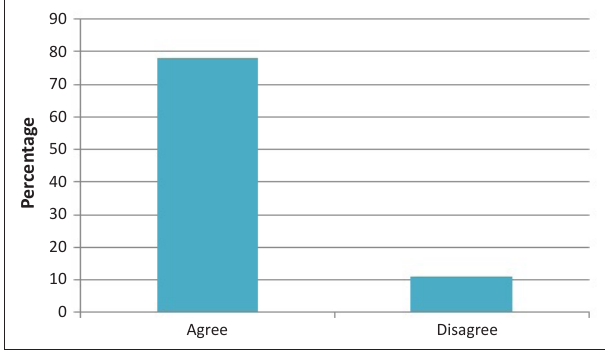
FIGURE 2: Current media successfully implemented.